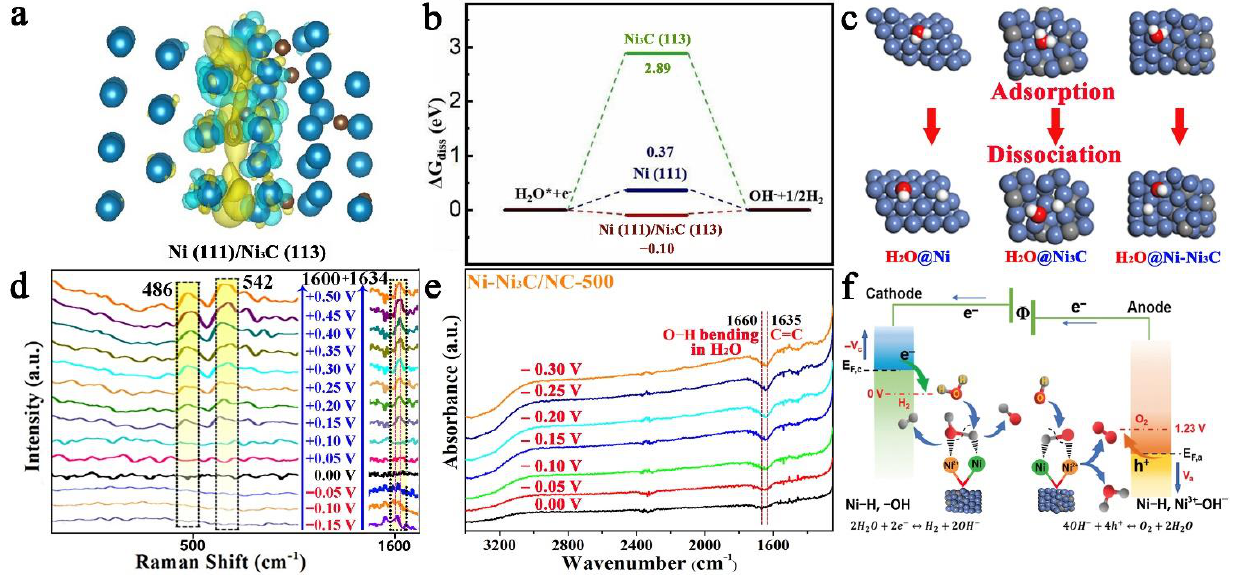
Figure 5. Interfacial electronic rearrangement and synergistic catalysis for alkaline water splitting. ( a ) Charge density difference map of Ni (111)/Ni 3 C (113) with an iso-surface value of 0.03 e Å −3 . ( b ) and ( c ) Gibbs free energy diagrams and the adsorption-dissociation of H 2 O on Ni (111), Ni 3 C (113), and Ni (111)/Ni 3 C (113) in an alkaline solution. Red and white balls represent oxygen and hydrogen atoms, respectively. ( d , e ) In-situ Raman spectrum and FT-IR spectrum measurements of Ni- Ni 3 C/NC-500 under different electrochemical potentials. ( f ) Schematic representation of the electro- catalytic OWS in alkaline media. −OH and Ni-H are the formed surface adsorbed intermediates during the HER process, whereas Ni-H and Ni 3+ -OH − are the observed surface intermediates during the OER process. The heterostructure electrocatalyst reduces the required driving energy and pro- vides paired synergistically catalytic sites, and thus realizes a highly versatile energy conversion efficiency.